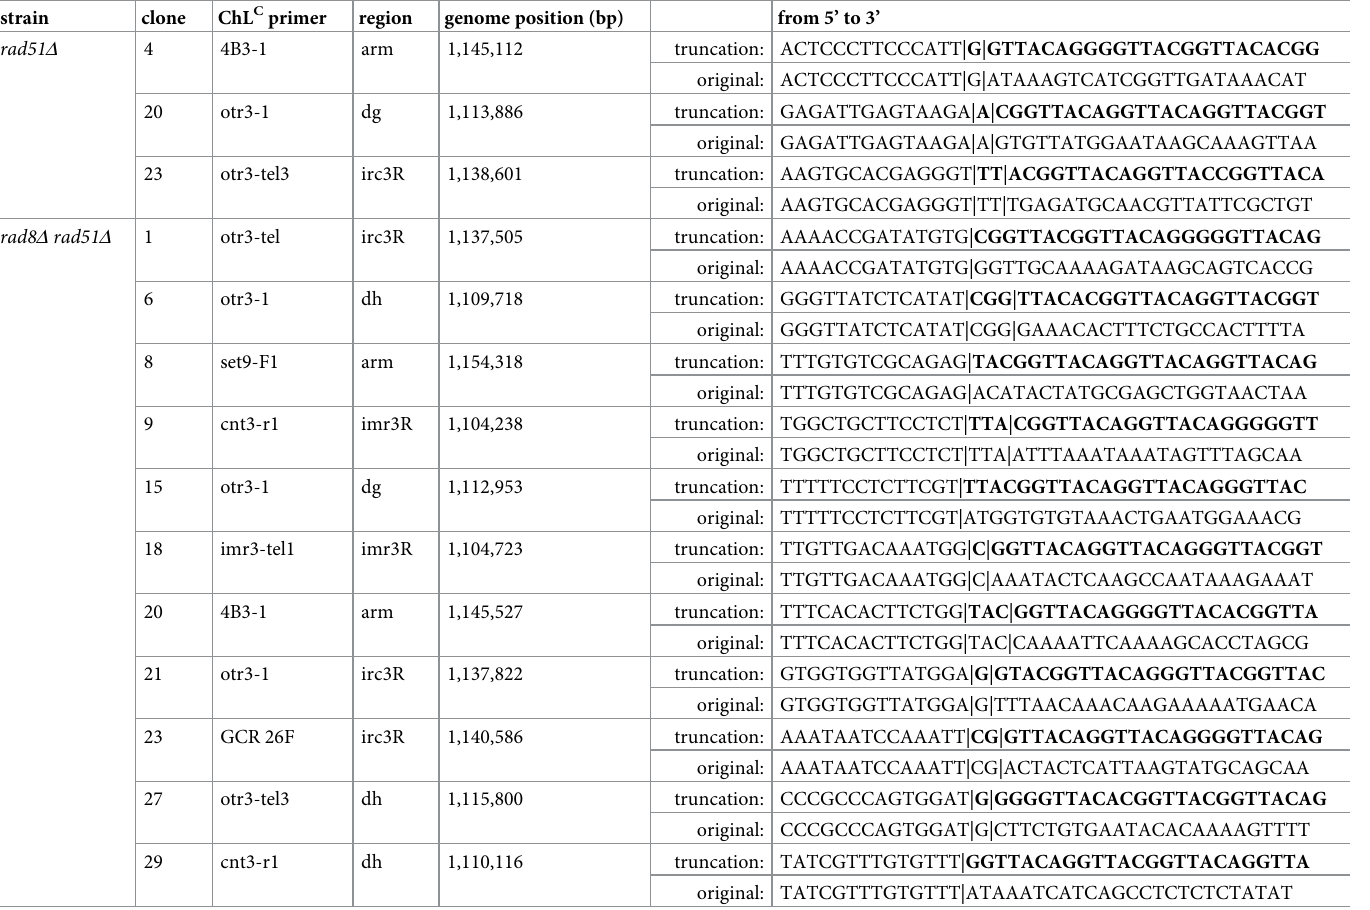
Table 2. Breakpoints of chromosomal truncations.